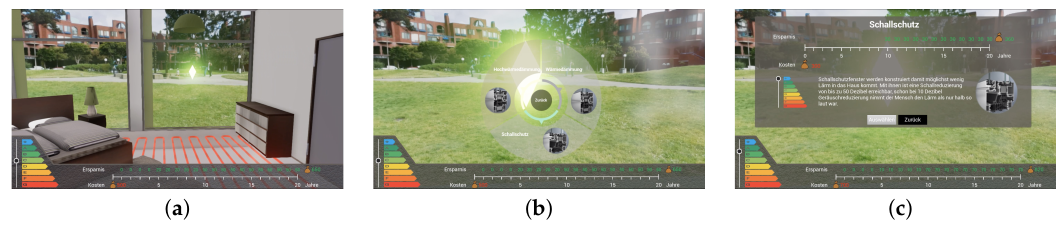
Figure 14. The 3D-Infokit prototype has a 3D game-like environment in which the user can navigate ( a ) and interacting with energy-related information to select from different options ( b ) and see the consequences of their choices ( c